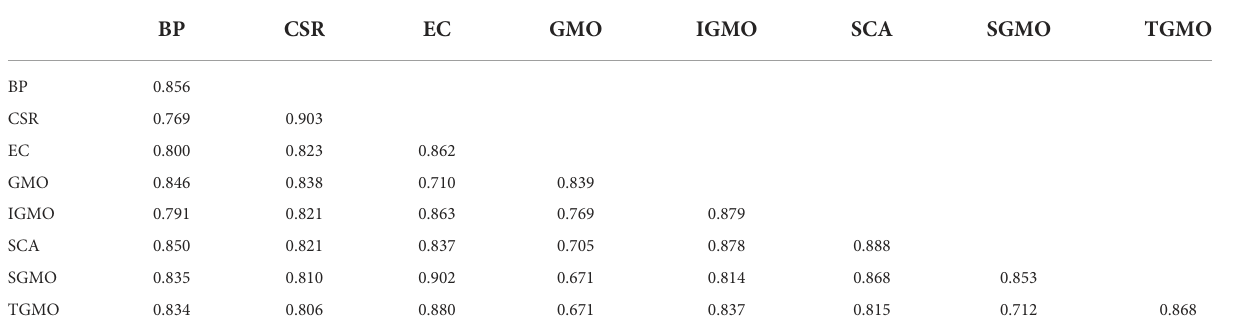
TABLE 3 Fornell-Larcker